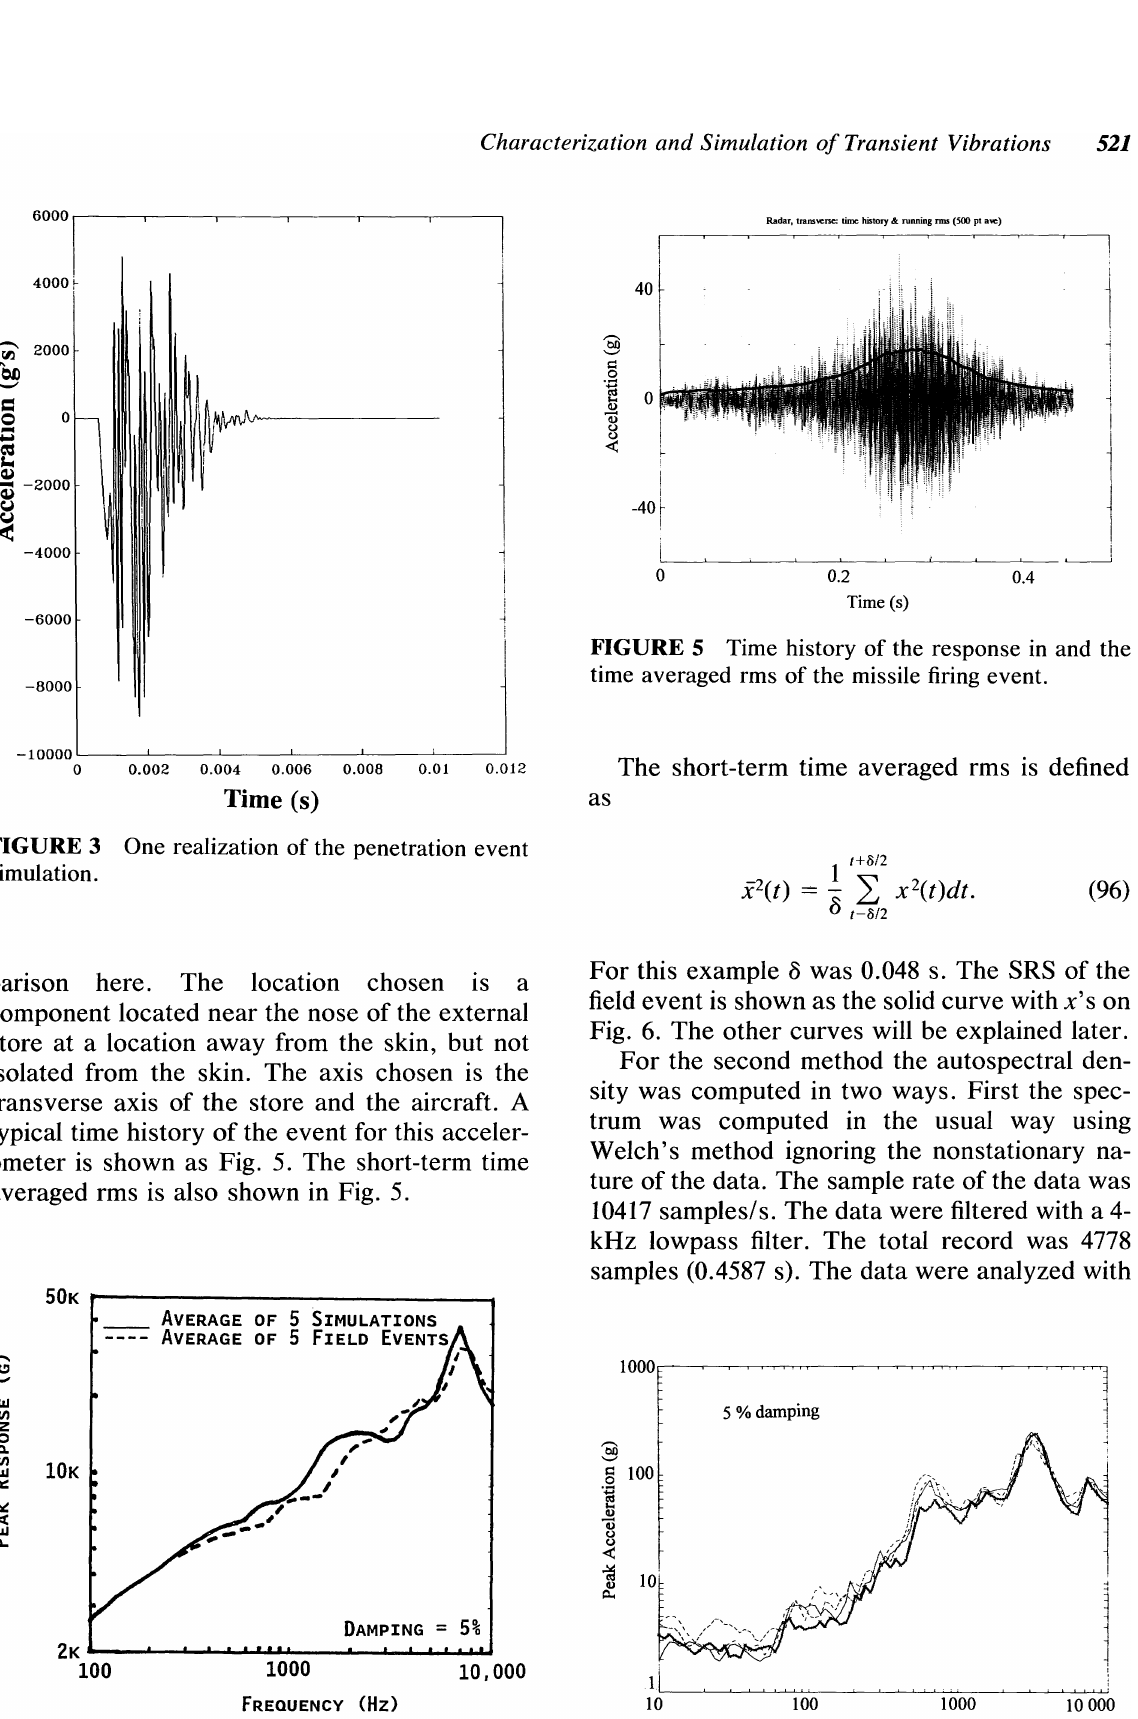
FIGURE 6 SRS of the time history of Fig. 5 and three